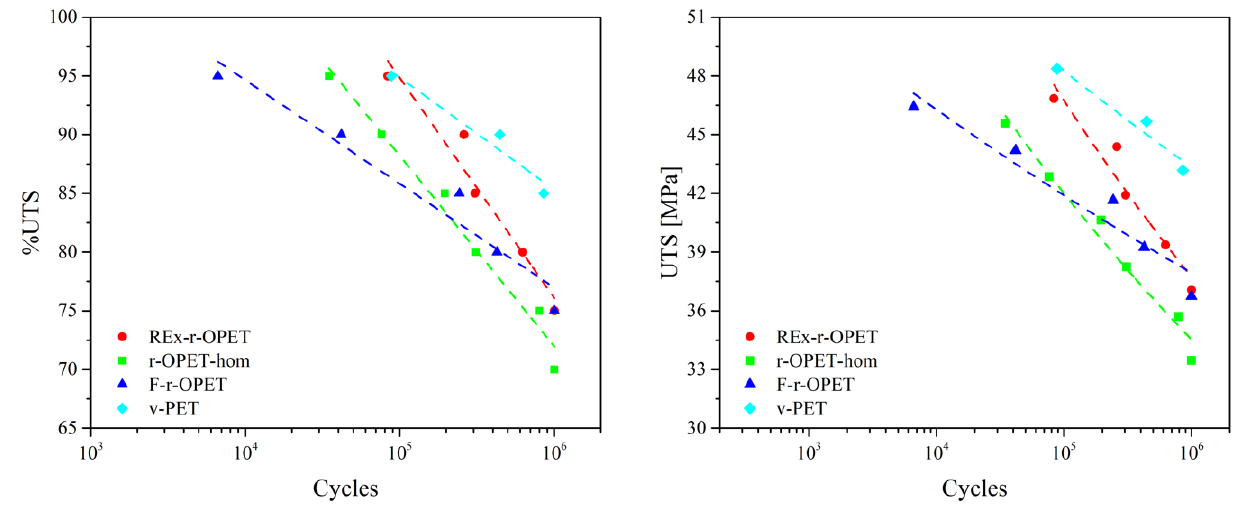
Figure 8. S-N curves of PET specimens fitted with logarithmic law ( left ) and Basquin law ( right ). Both presented models fit well the studied materials and are comparable. The